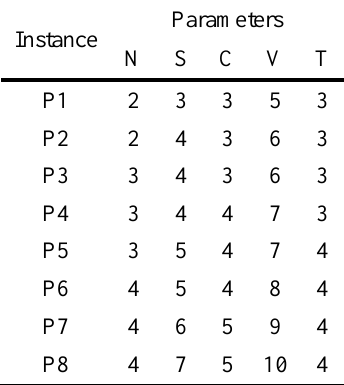
Table 8. Size and parameters of the eight randomly generated instances